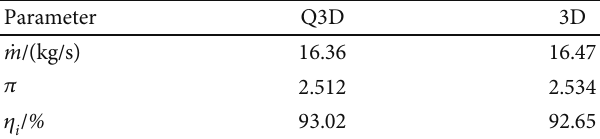
Table 4: Overall performance results of the two-stage turbine.